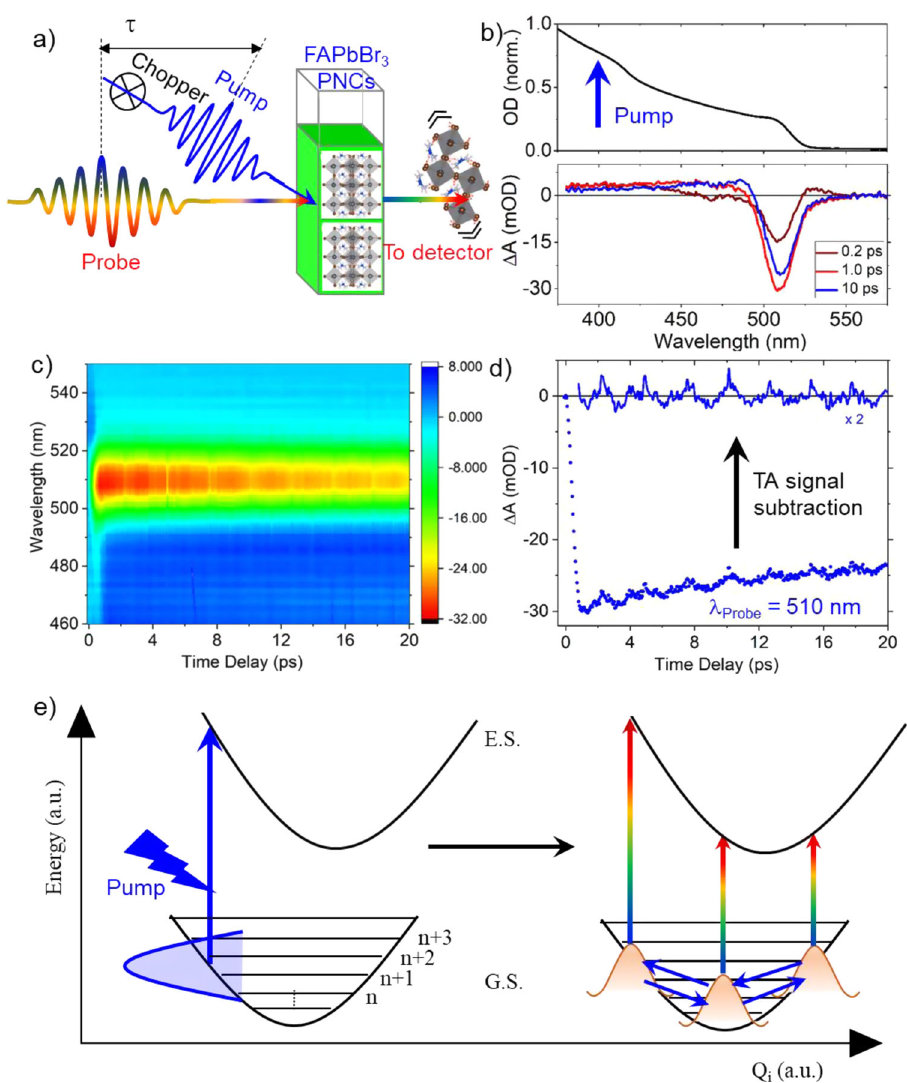
Fig. 2 Vibrational wave-packet dynamics. a Schematic of the ultrafast pump – probe experiment on FAPbBr 3 PNCs. b , c Chirp-corrected transient differential absorption ( ΔΑ ) spectra of the FAPbBr 3 PNCs depicted at speci fi c time delays of 0.2, 1, and 10 ps, and in a contour diagram, respectively. The color bar in c represents ΔΑ (mOD). The linear absorption spectrum is also shown on the top panel of b for comparison. The PNCs are excited with a ~100 fs laser pulse at 400nm (excitation photon density ~3.5 × 10 13 cm − 2 ). d The time trace obtained at 510 nm is shown as a blue dotted line. The residual time trace, obtained after subtraction of the exponential fi t, is also shown as a blue line. e Illustration of a vibrational wave packet motion along a particular phonon displacement coordinate of PbBr 6 4 − octahedral, generated by the interaction of the pump pulse with the PNCs. The vertical and horizontal axes denote the potential energy and phonon displacement coordinate Q i , respectively. The interaction of the above bandgap pump pulse with the PNCs leads to the generation of wave packets in the ground state (G.S.), as well as the excited state (E.S., not shown). Subsequently, the wave packet starts oscillating at the ground state from its origin, far from its equilibrium position, which can be detected by the time – dependent probe pulse at the bleach position. NATURE COMMUNICATIONS| (2021) 12:2629